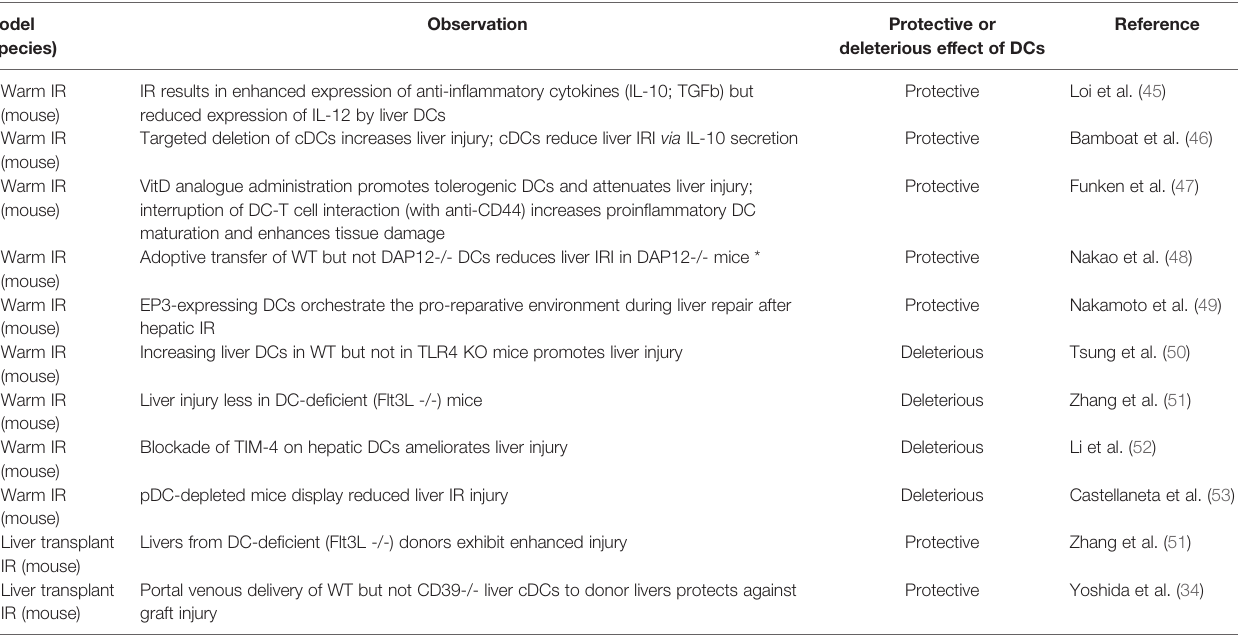
TABLE 1 | Regulation of liver ischemia-reperfusion injury by intra-hepatic dendritic cells. Model